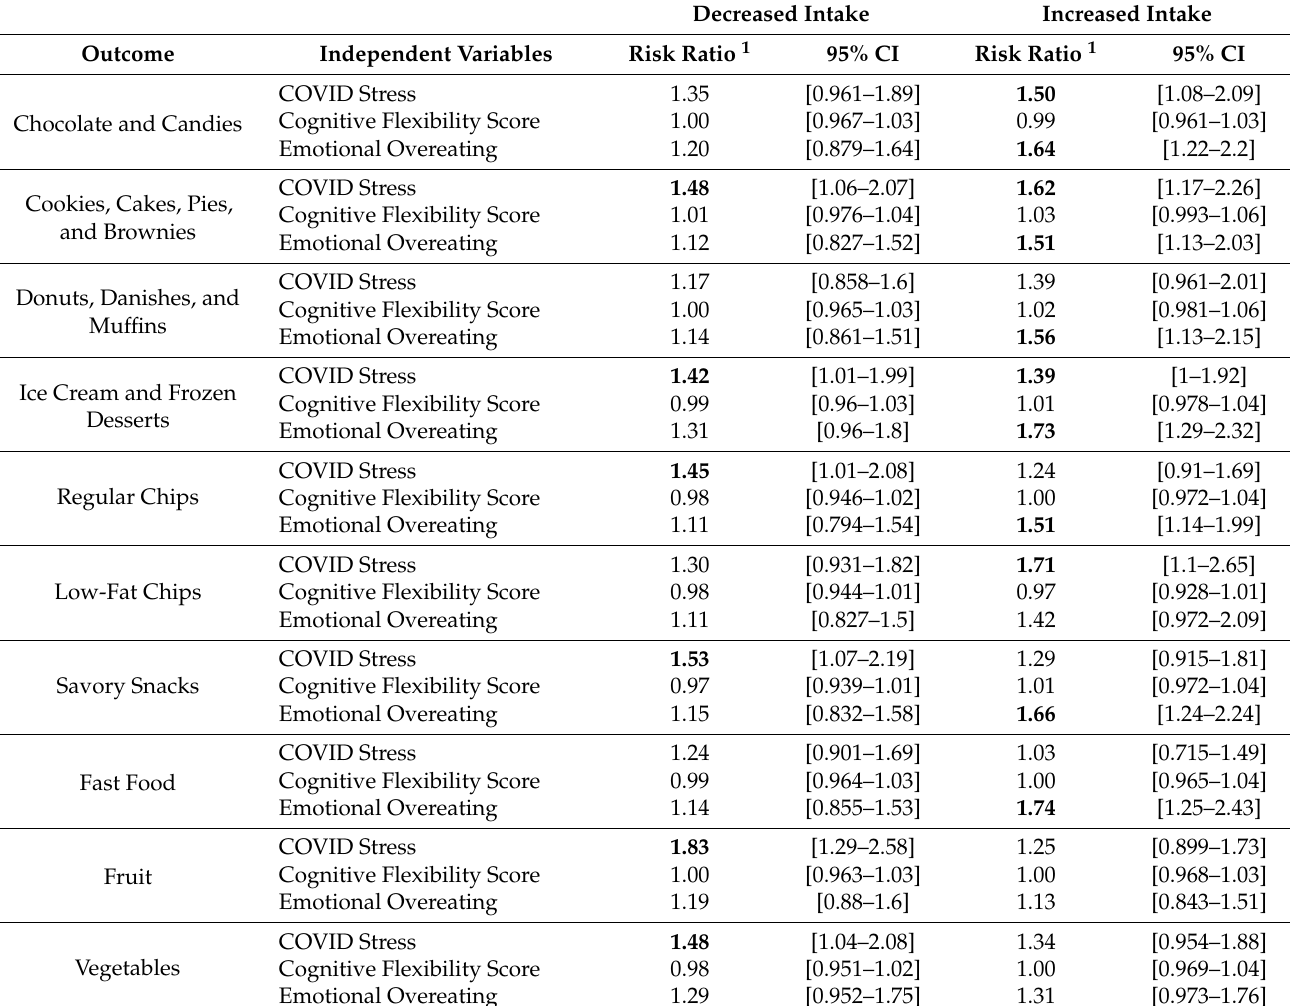
Table 5. Best-fit multinomial logistic regression models of COVID-19-related stress, emotional overeating, and cognitive flexibility associated with food intake change during COVID-19 ( n =